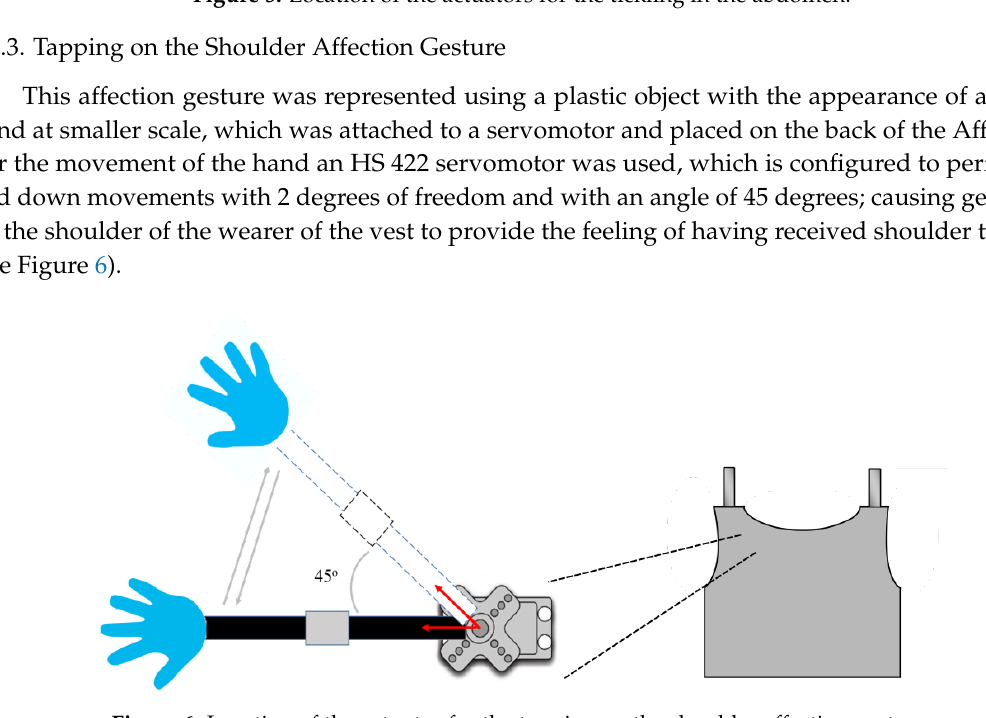
Figure 6. Location of the actuator for the tapping on the shoulder affection